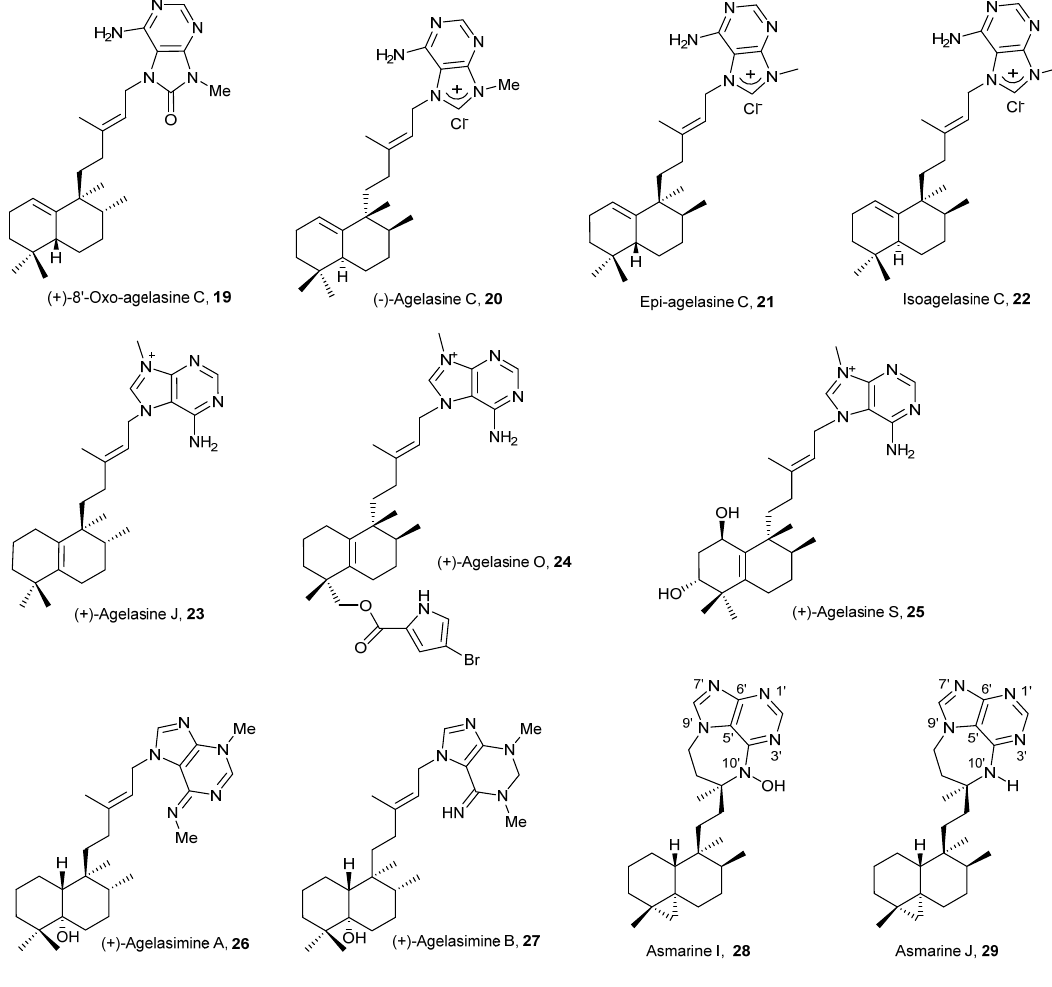
Figure 7. Halimane-purines. Figure 7. Table 3. Natural sources and activities of halimane-purines.